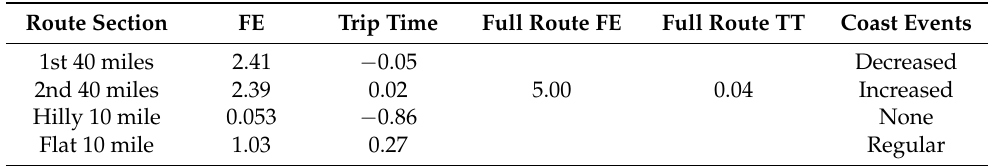
Table 8. Predictive fuel economy numbers for different section of the route. Route